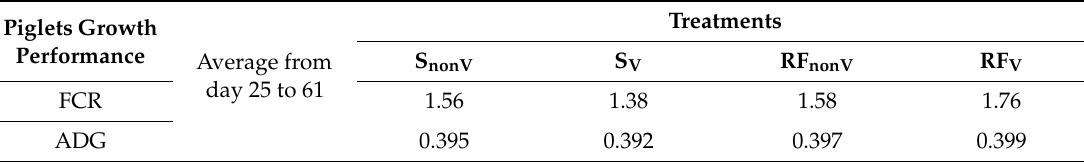
Table 5. Influence of the analysed factors and their interactions on piglets’ growth performance. Piglets